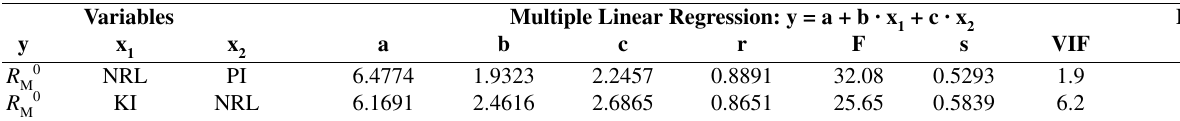
Table 4. Statistical parameters for multilinear dependence between R M0 and calculated descriptors. Variables